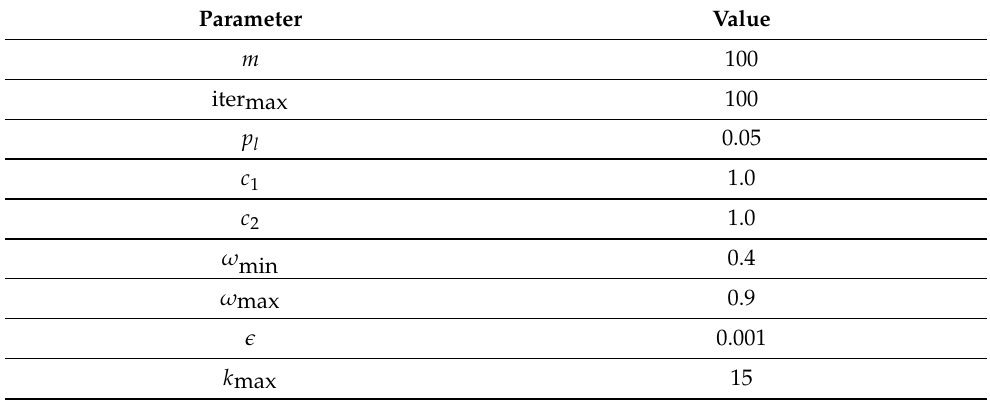
Table 1. Values for the experimental